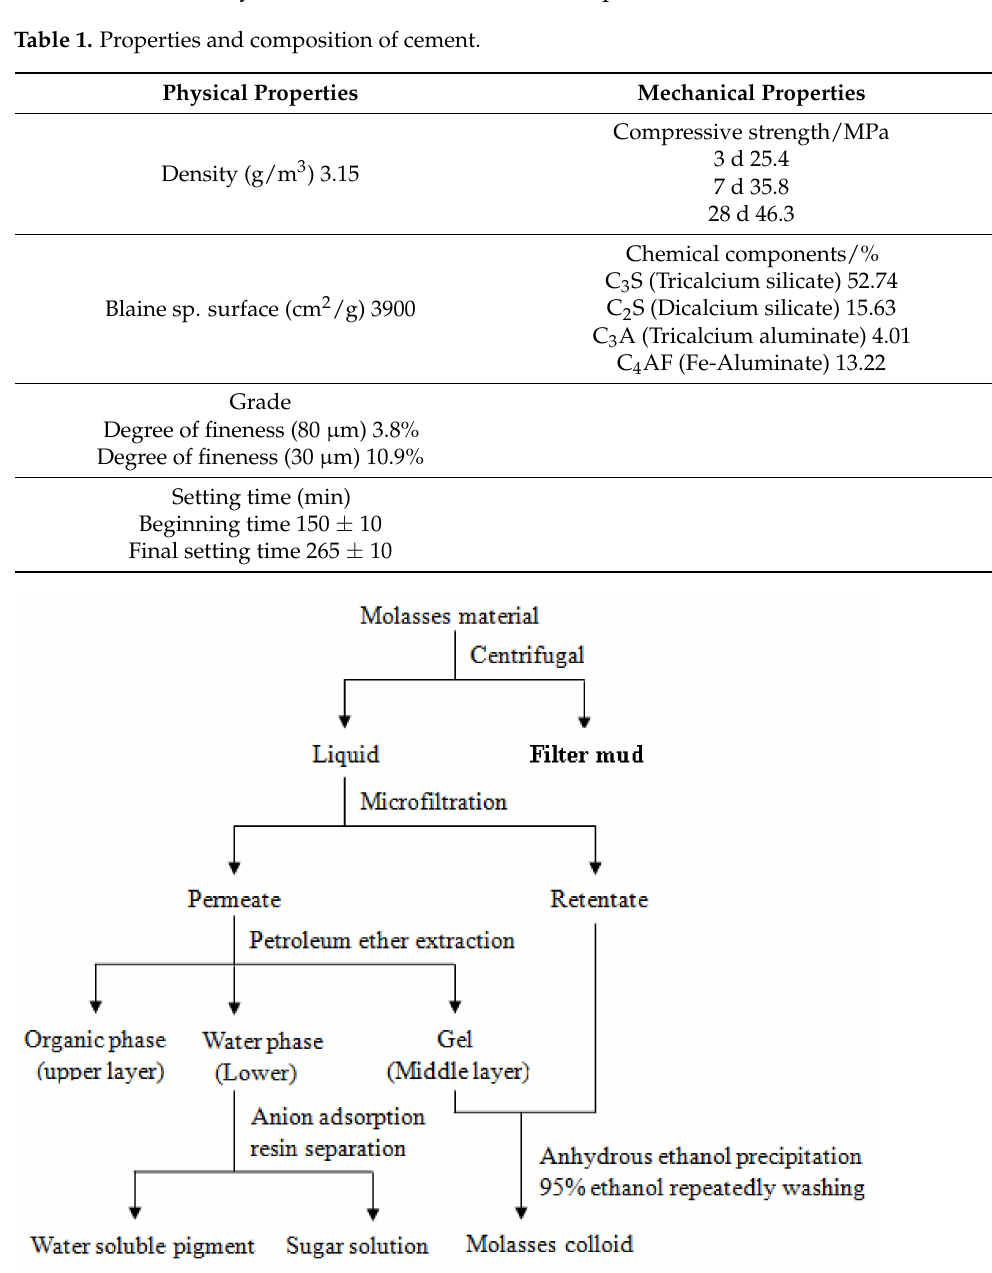
Figure 1. Separation steps of molasses raw material. Table 2. The distribution of molasses